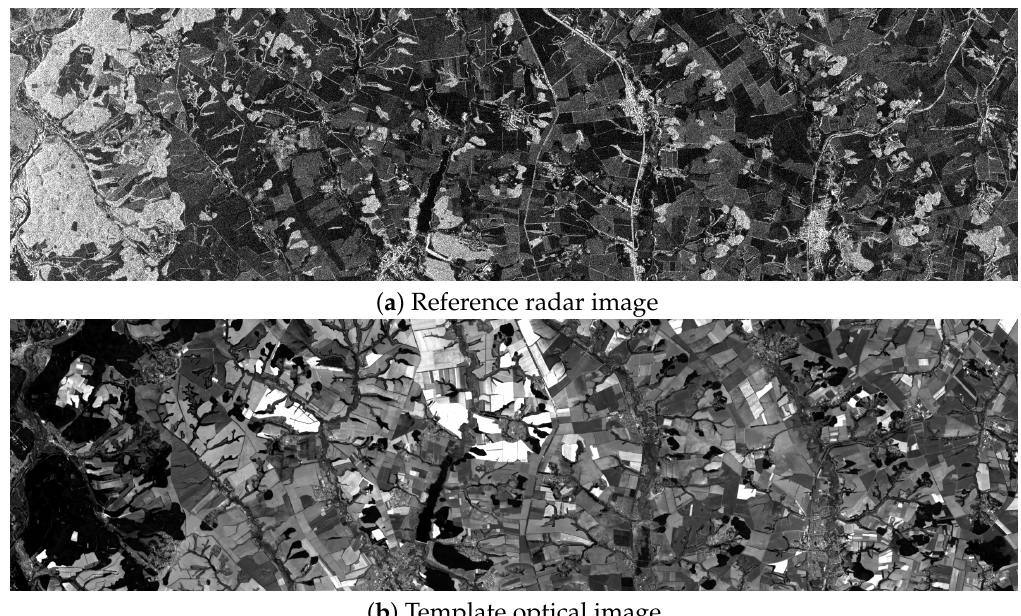
Figure 5. Example of one training image pair. ( a ) reference radar image acquired by Sentinel-1 and ( b ) template optical image acquired by Landsat-8.